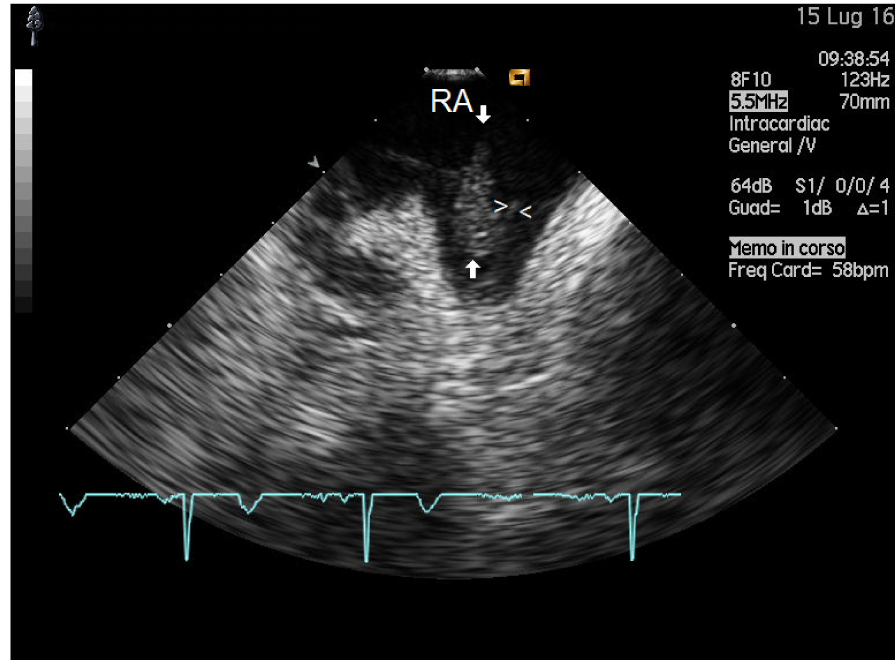
Figure 3. Lead infective endocarditis of larger sizes. Example of a mass attached to the terminal portion of an atrial catheter (indicated by white arrowheads) before its implantation in the right atrial appendage wall, as visualized by a specific plane orientation that transects the right atrium and right atrial appendage by means of a slight retroflexion of the probe head from a home view. This demonstrates the high potential of ICE in visualizing cardiac structures that are not accessible with other imaging modalities. The vegetation (indicated by the white arrows) has a “round shaped pedicular growth” type morphology, an iso-hyperechogenic appearance, size 14 x 8 mm, and it is attached with a sessile base to the lead with a high grade of mobility. The patient underwent successful extraction of the infected device. ICE = intracardiac echocardiography; PM: implantable cardioverter defibrillator; RA: right atrium; at the bottom (in blue) electrocardiogram tracing of the patient, simultaneously